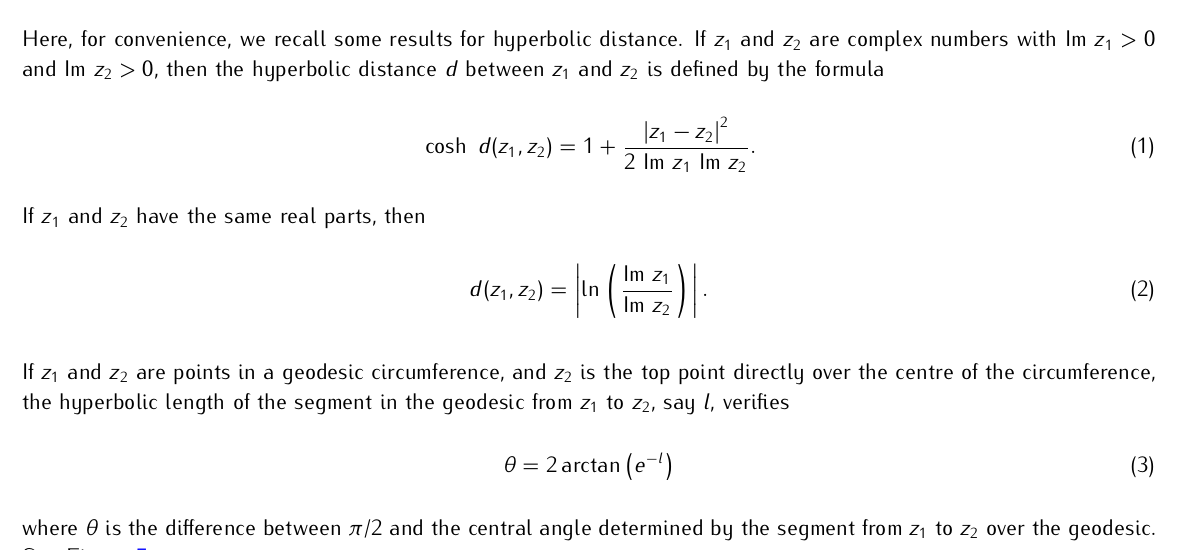
The circumferences and straight lines appearing in the definitions of piecewise functions w L and w R are orthogonal to the line Im z = 0, and are geodesics in the Poincare half-plane. The expressions for functions w L and w R are isometries in the half-plane hyperbolic model since they have the form The functions w L and w R are symmetric with respect to the circumferences and to the straight lines which appear on the boundary of two neighbouring zones of the normalized